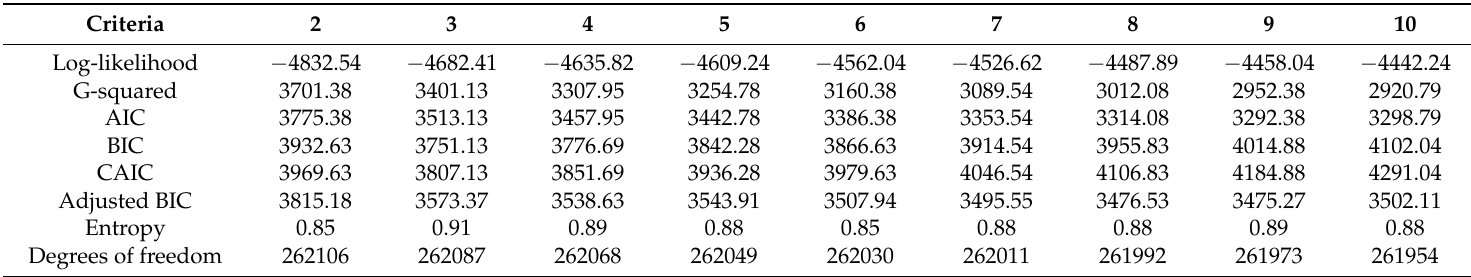
Table 3. Fit statistics for latent class models of young female fatal crash factors.